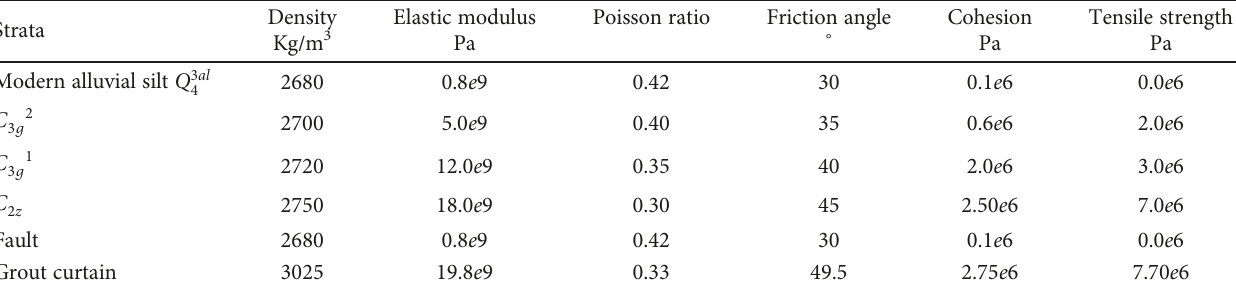
Table 1: Material parameters.